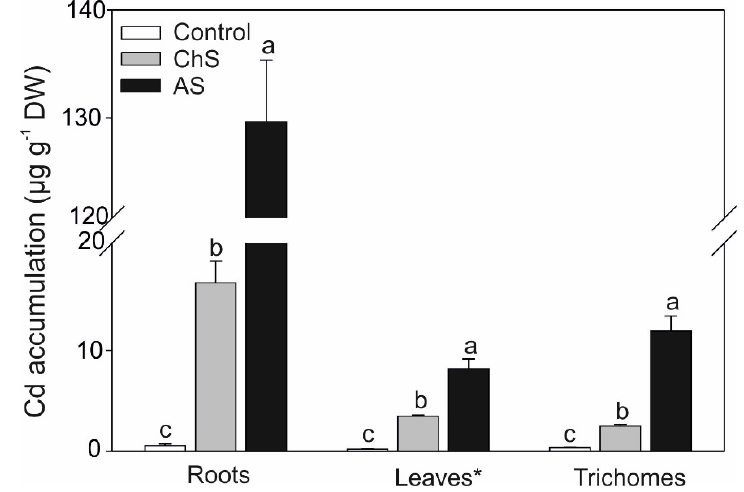
Figure 2. Effect of long-term chronic cadmium stress (ChS, 0.1 µM Cd, 85 days) or short-term acute cadmium stress (AS, 10 µM Cd, 4 days) on the Cd accumulation in the roots, leaves (* leaves without trichomes), and trichomes of C. acaulis . Data are means ± SE ( n = 5); values followed by the same letter are not significantly different ( p < 0.05, Tukey’s test).